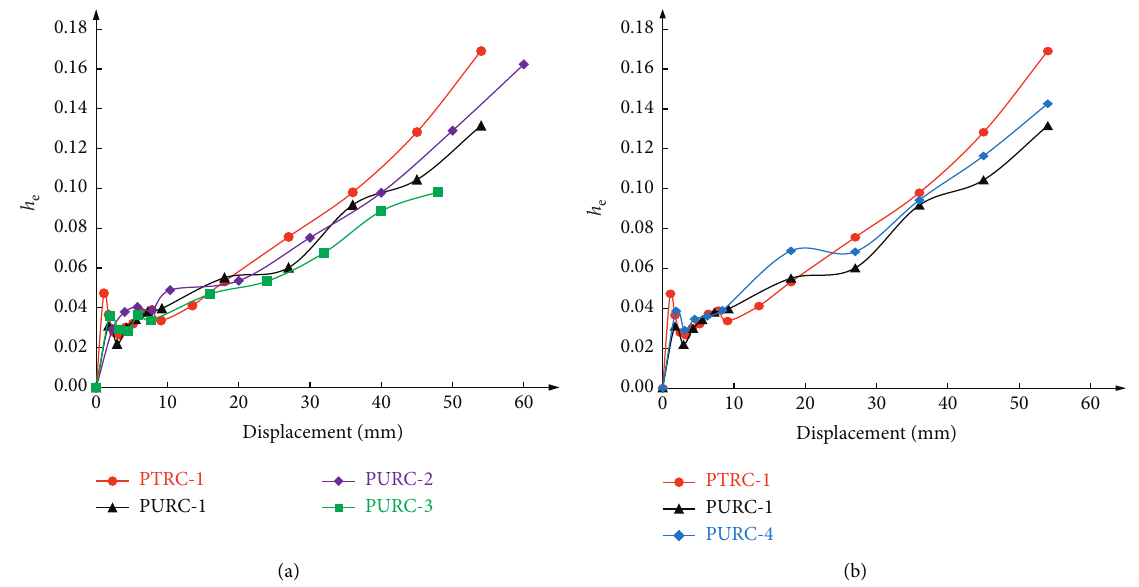
Figure 9: Comparison of equivalent damping